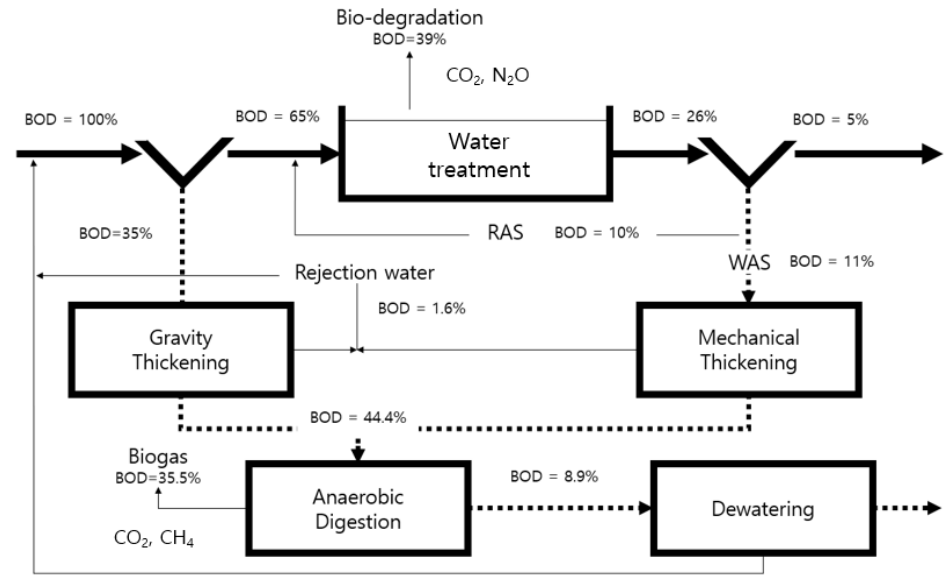
Figure 1. Material flow chart (BOD of wastewater) for wastewater treatment plants. RAS is returned activated sludge, WAS is wasted activated sludge.